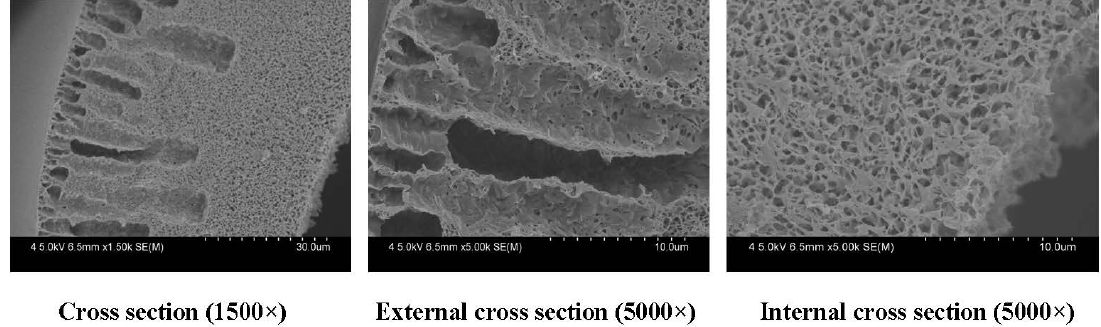
Figure 14. The cross-section of F60S membrane by SEM; the inner diameter and different wall thickness of PVDF hollow fiber membranes are 200 and 40 μ m,